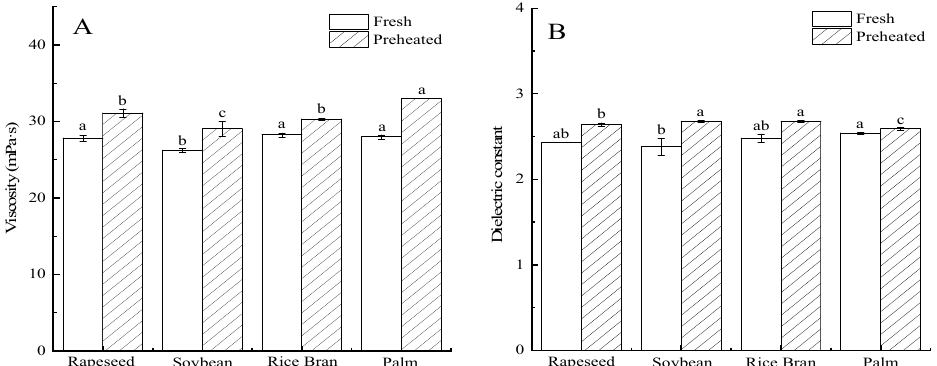
Figure 1. ( A ) Viscosity and ( B ) dielectric constant of fresh and preheated frying oils at 180 °C. Mean values listed in columns with different letters indicate statistically significant differences ( p < 0.05) .